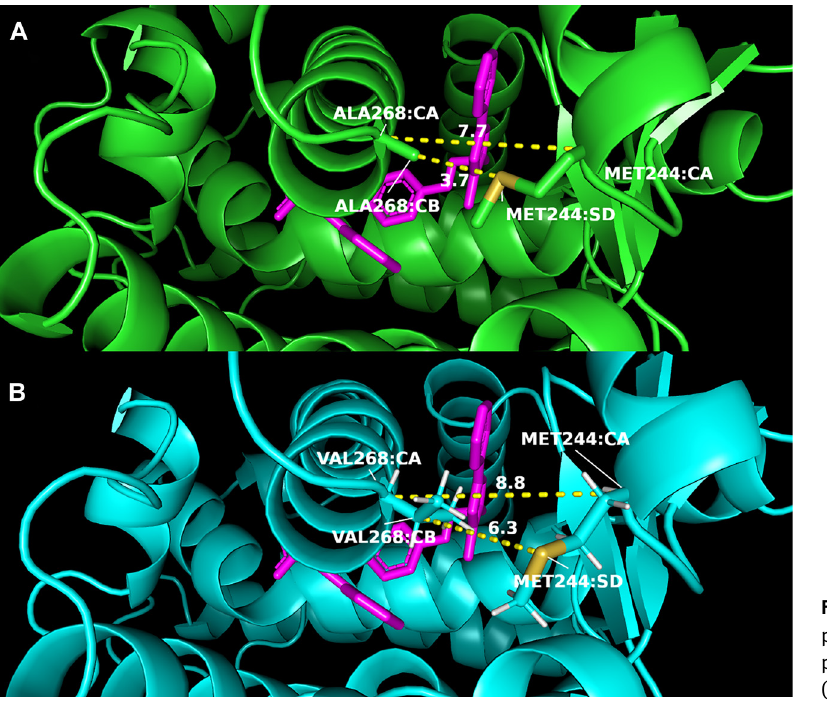
Figure 5: Cartoon representation of positional changes in the A268V polymorphic region. (A) Wild type PPARA, (B) polymorphic